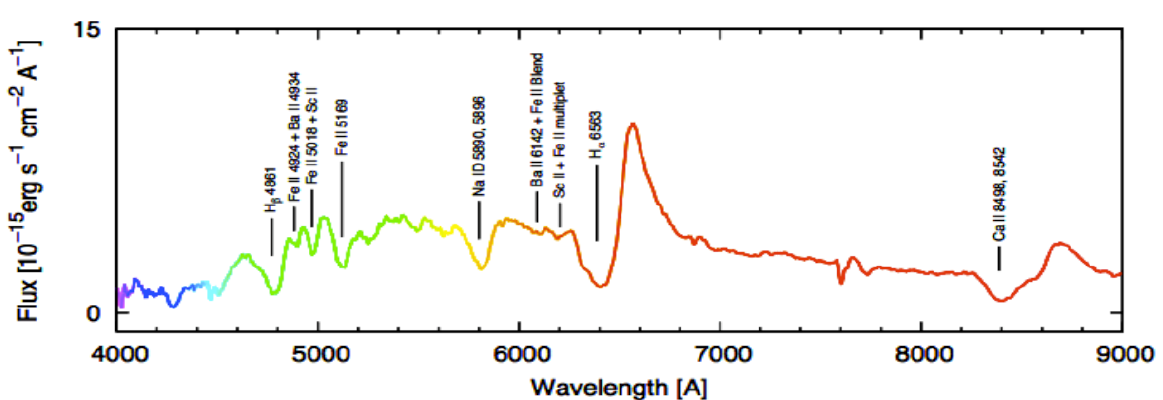
Figure 3. First-light spectrum from the low dispersion spectrograph/imager on the 3.6-meter Devasthal Optical Telescope (DOT) of the Type II-P supernova, SN 2017gnr (Omar et al.